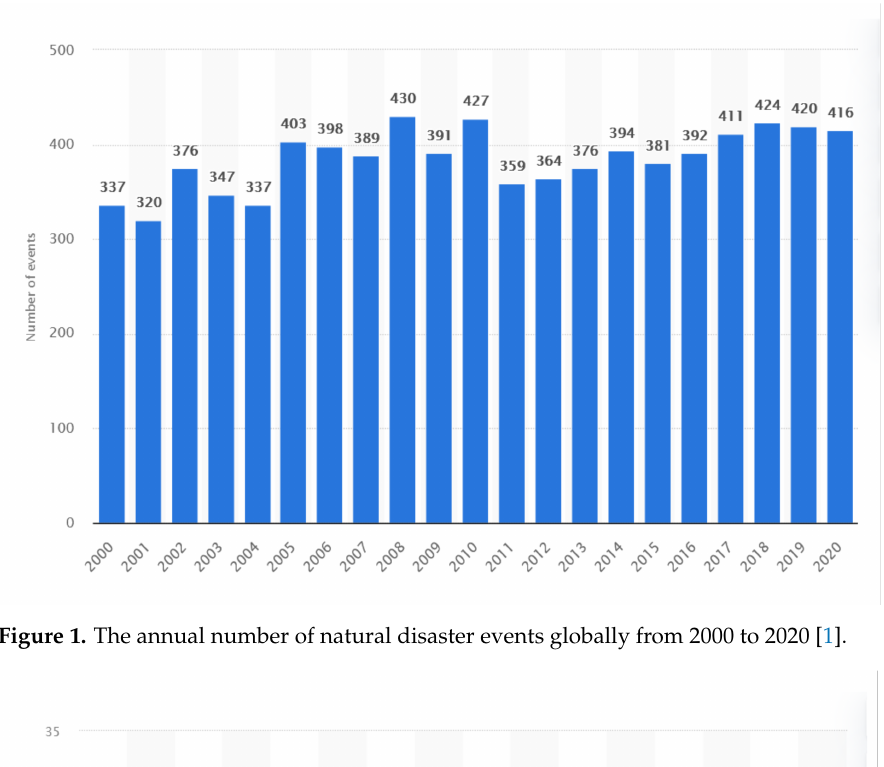
Figure 1. The annual number of natural disaster events globally from 2000 to 2020 [1].